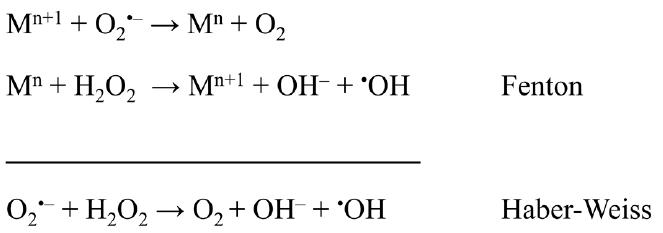
Figure 4. Fenton and Haber–Weiss reactions as a source of oxidative stress, where M = Fe, Cu, and n = charge of metal ion [126,127].